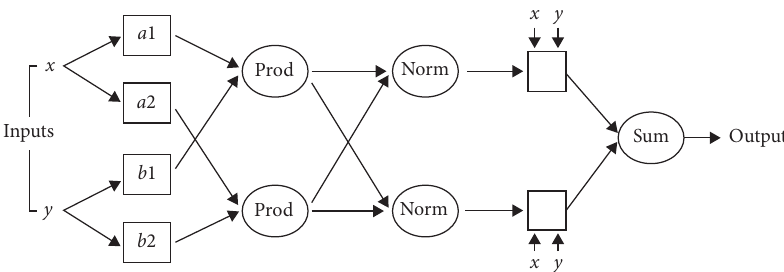
Figure 6: The basic structure of a hybrid neuro fuzzy inference